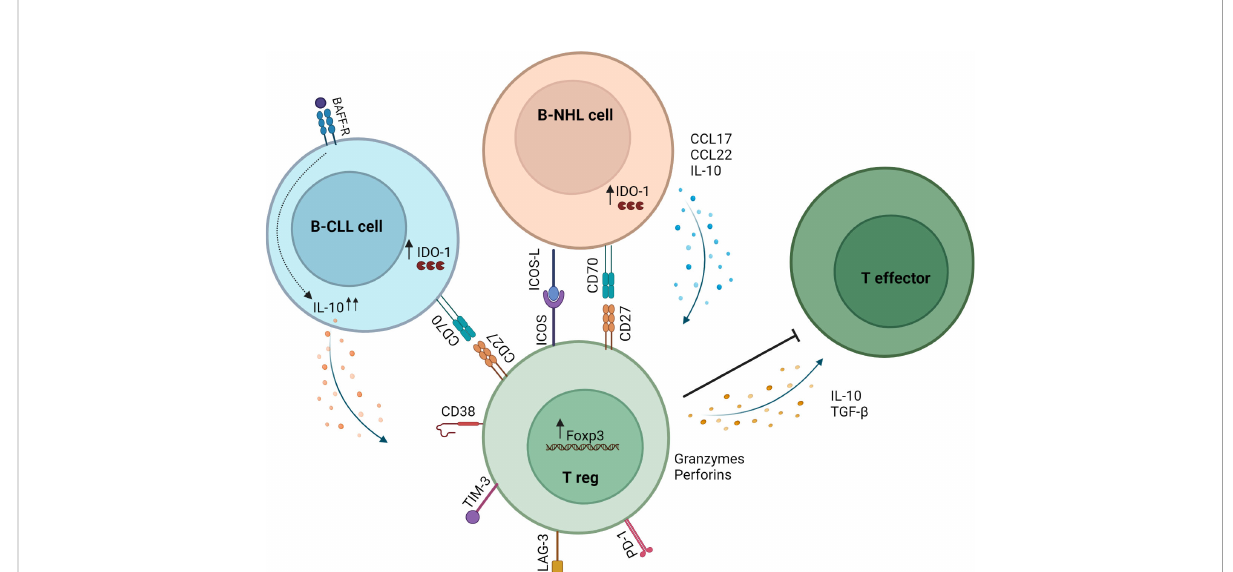
FIGURE 1 Mechanisms of Treg induction and action in the B-NHL microenvironment. B-NHL and CLL cells can induce Tregs via direct contact with T cells in the tumor microenvironment and through secretion of soluble factors. In B-NHL and CLL, Tregs can inhibit the immune response through the secretion of IL-10 and TGF- b or by killing effector T cells via release of granzymes and perforins. Tumor-in fi ltrating Tregs in B-NHL and CLL also exhibit high expression of immune checkpoint molecules such as PD-1, LAG-3 and